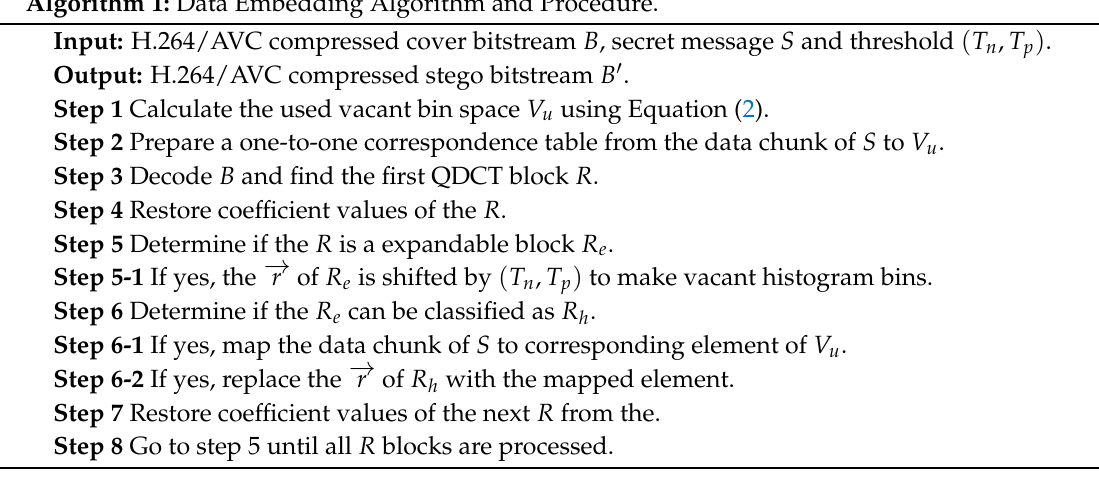
Algorithm 2: Data Extraction Algorithm and